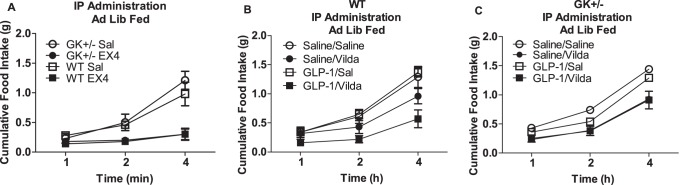
The impact of glucokinase on the anorexic effect of GLP-1 in fed animals.a) Food intake was equally suppressed in WT (squares) and GK+/− (circles) mice after IP injection of EX4 (solid symbols) vs. saline (open symbols; *p<0.05 at 4 h after injection). Food intake was also equally suppressed at 4 h by IP GLP-1+vildagliptin in WT (b) and GK+/− (c) mice (*p<0.05 at 4 h post-injection). For b) and c), open circle, IP saline+IP saline; closed circle, IP saline+IP vildagliptin; open square, IP GLP-1+IP saline; closed square, IP GLP-1+IP vildagliptin.